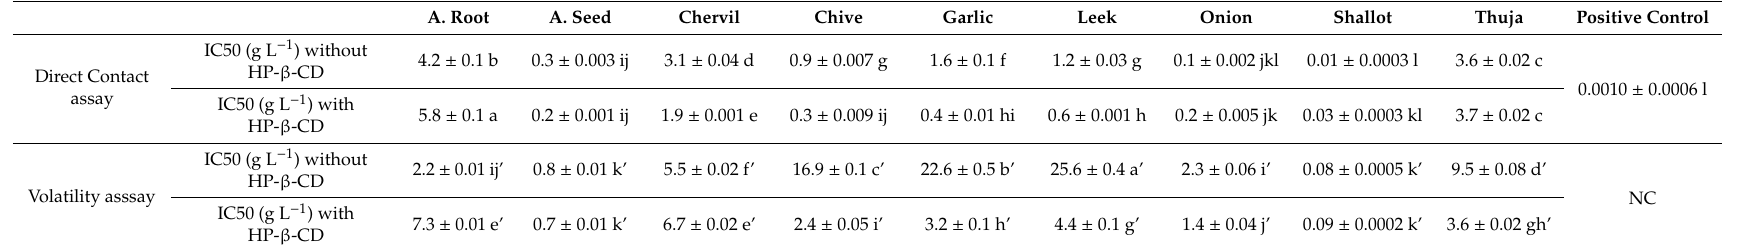
Table 3. IC50 of antifungal activity of EO obtained by both direct contact assay and volatility assay.